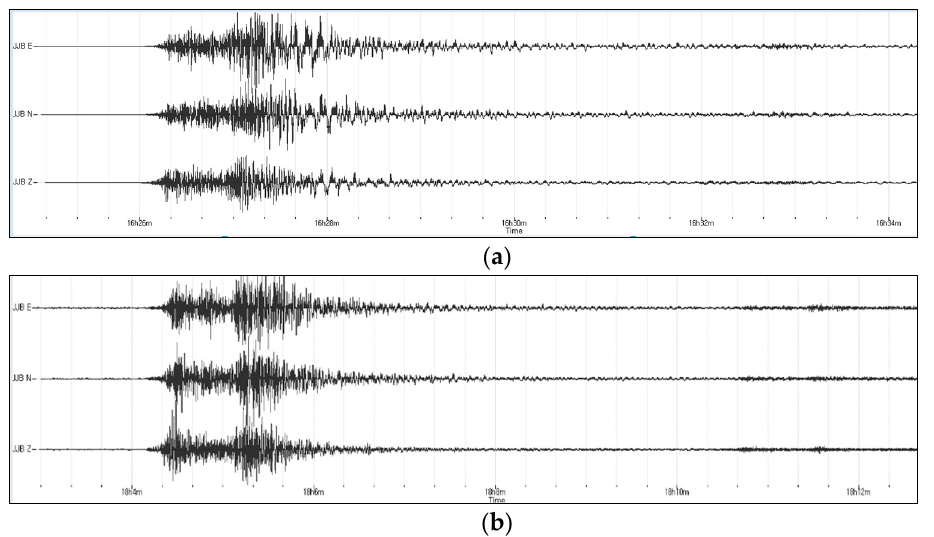
Figure 2. Three-component time history waveforms (EW, NS, UD) of the main earthquake (M, 7.3) and aftershock (M, 5.7) among the Kumamoto earthquake series at JJB station are shown in ( a ) and ( b ), respectively.